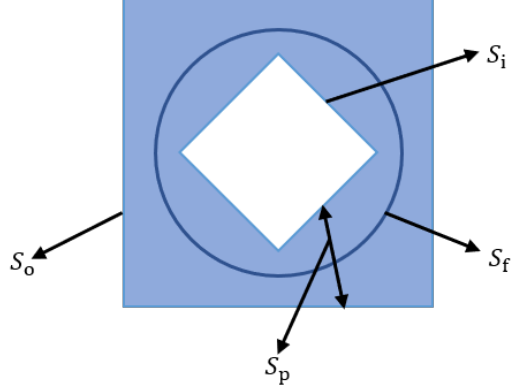
Figure 4. Relationship of the threefold structuring elements in our improved NWTH transformation. S p consists of S i and S o , S p and S f represent structural elements for dilation and erosion operations, respectively.